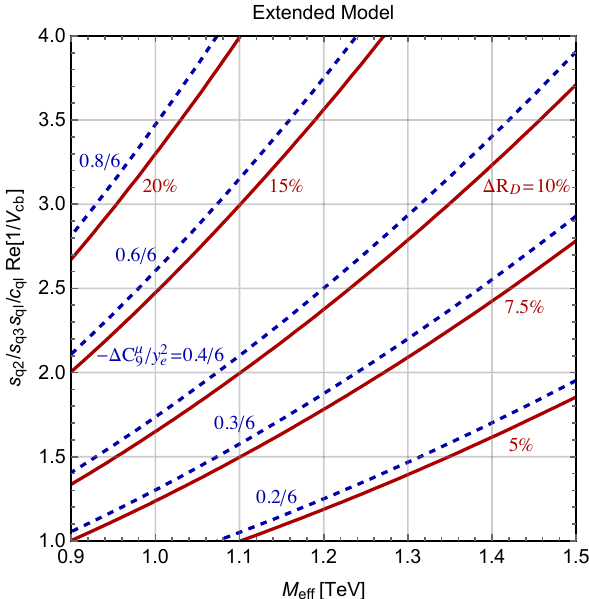
% and ∆ C µ = /y 2 e 9 } −